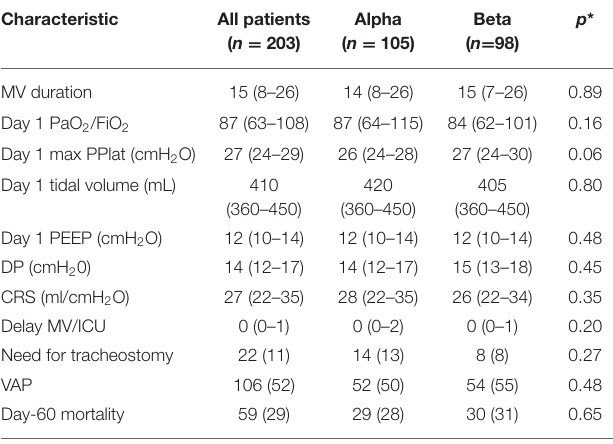
TABLE 2 | Comparison of the 203 Alpha- and Beta-infected patients who underwent mechanical ventilation in terms of mechanical ventilation characteristics and day-60 mortality.